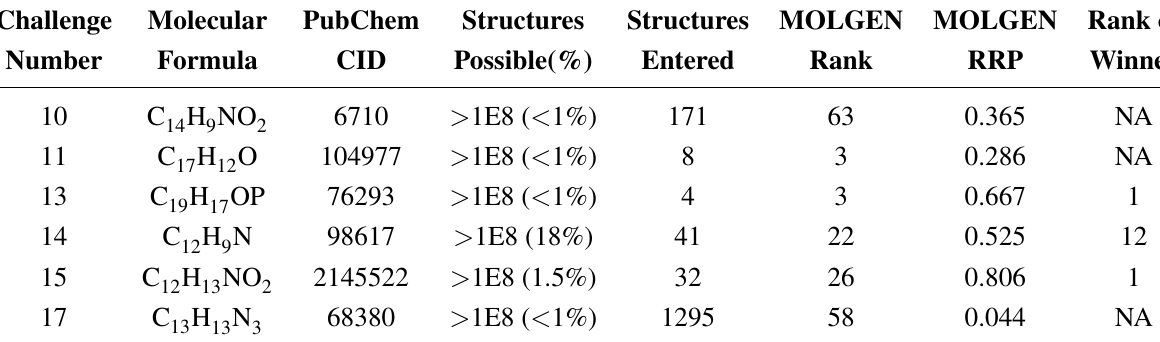
Table 2. MOLGEN results for Category 2 (best molecular structure for LC–MS/MS). NA is not applicable ( i.e . no